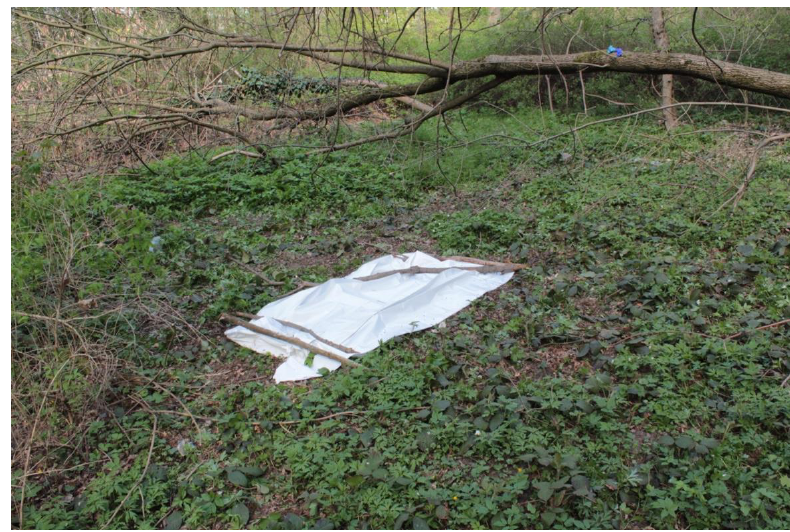
Figure 1. The site of the corpse disclosure, 22 April 2019. Photo—M. Michalski. The corpse was dressed in an undershirt and long denim trousers. The head and torso were almost completely skeletonized. Soft tissues of the upper back and the proximal parts of the upper limbs were mummified. The lower parts of the back and the tissues of the lower limbs, covered by denim trousers, had changed to adipocere. Gnaw marks on the feet phalanges and the presence of faeces indicated the activity of vertebrate scaven- gers. Based on the morphological features of the skeleton examined by the forensic phy- sician, it was initially estimated that the human remains belonged to a woman aged 25– 45 years. During the examination, as well as during the subsequent autopsy, no ante- mortem injuries were found. Therefore, it was impossible to establish the circumstances and cause of death. After the body examination, the remains were taken to the morgue. The entomolog- ical material was collected at the site of their disclosure the next morning. The supplemen- tary material was collected during the autopsy and subsequent body examination on the 23 April 2019. The collected material was preserved in 75% ethyl alcohol. Imagines of predatory beetles, from the families Staphylinidae and Histeridae, were most dominant on the corpse. A few specimens of Omosita spp. (Nitidulidae), Necrobia violacea Linnaeus, 1758 (Cleridae), Thanatophilus sinuatus (Fabricius, 1775), and Oiceoptoma thoracicum (Linnaeus, 1758) (Silphidae) were also found. Among the flies, the most abun- dant were larvae of the Piophilidae family feeding in the adipocere. Numerous larvae and pupae of Fannia sp. were collected from the folds of the clothes, and a few Muscid larvae belonging to the genera Hydrotaea Robineau-Desvoidy, 1830 and Muscina Robineau- Desvoidy, 1830 were collected from the soft tissue residue . Three empty puparia of Chrysomya albiceps (Wiedemann, 1819), attached to clothing, were the only indicators of the presence of blow flies. Several larvae, ~1 cm long, were collected from the folds of the clothes covered with litter and adipocere formed on the back and lower limbs of the corpse. The specimens, covered with moist soil mixed with organic matter, were preliminarily identified as larvae of H. illucens . After cleaning in an ultrasonic cleaner, the surface of the larvae was re-ex- amined and showed a clear striped pattern, uncharacteristic for H. illucens . On the 1 October 2019, numerous mature specimens of Sargus bipunctatus were found in the compost and manure dumping place in the Łódź Zoo, located approximately 1.1